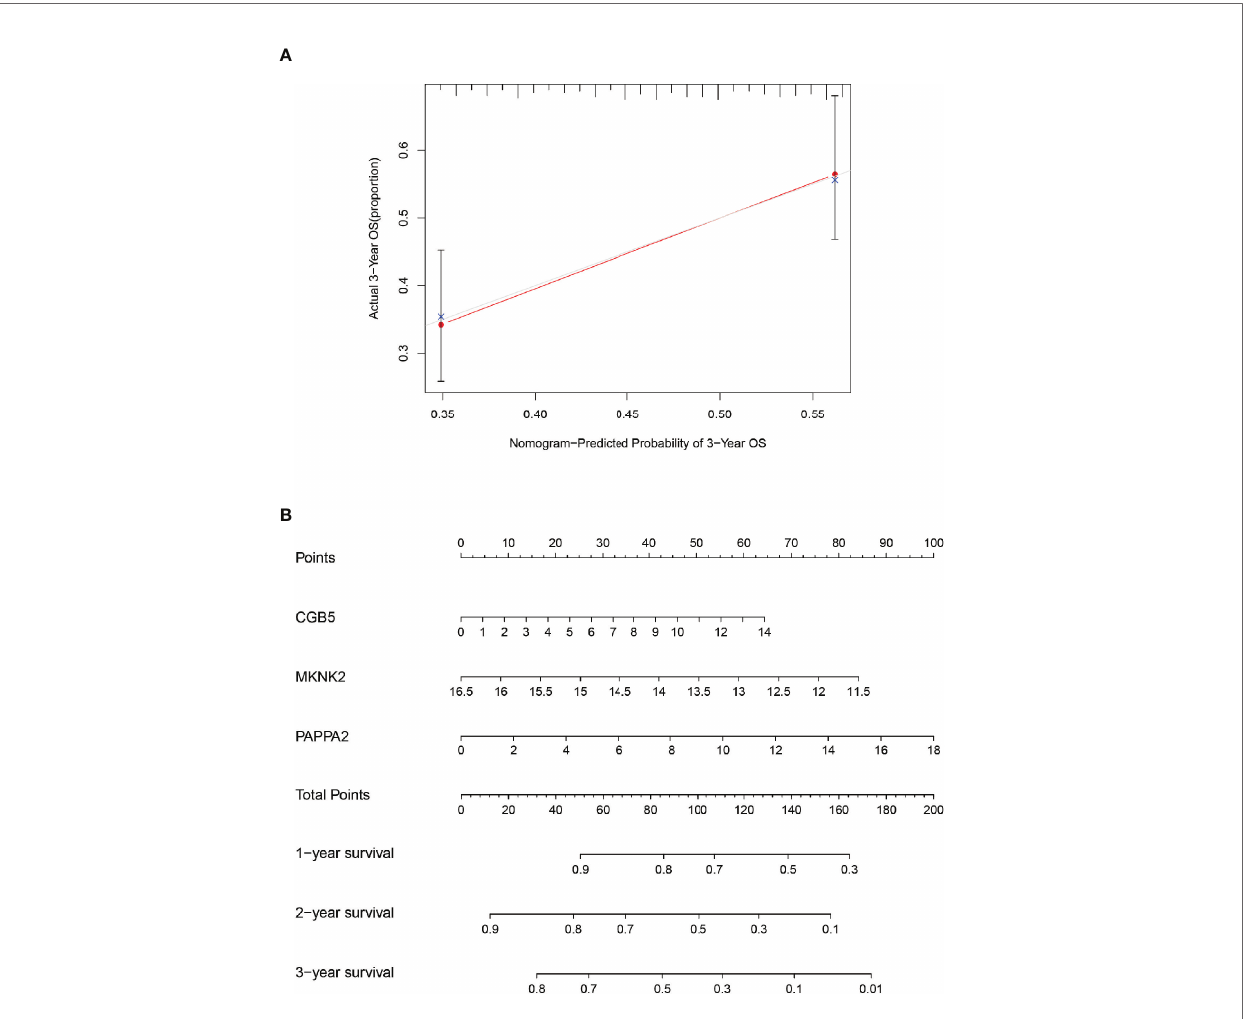
FIGURE 10 | Calibration and column line diagrams. Chart (A) , the red line segment indicates actual survival and the gray line segment indicates predicted survival, which almost overlap. The (B) -plot represents a column line plot constructed based on three genes and 3-year scores for predicting survival.